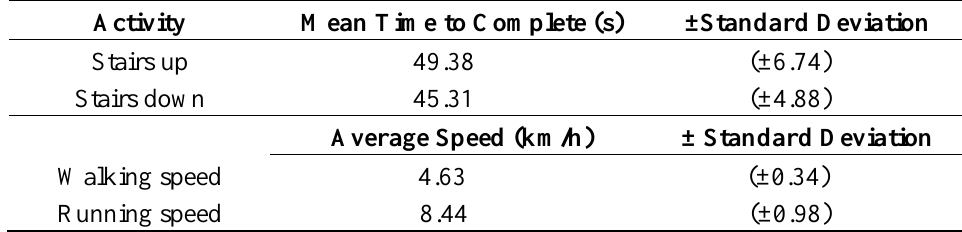
Table 2. Summary of the time taken to complete walking and stair walking tasks and mean speed for walking and running on a treadmill. Figures presented are average and ± standard